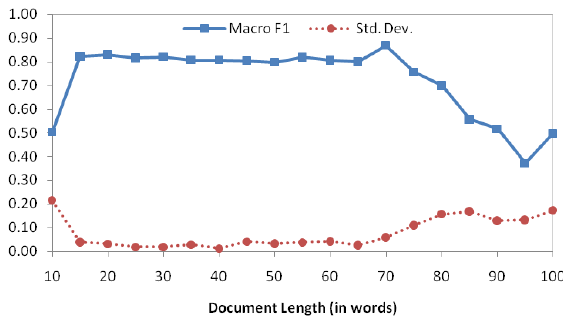
Fig. 10. Classification performance with respect to document length (in words)